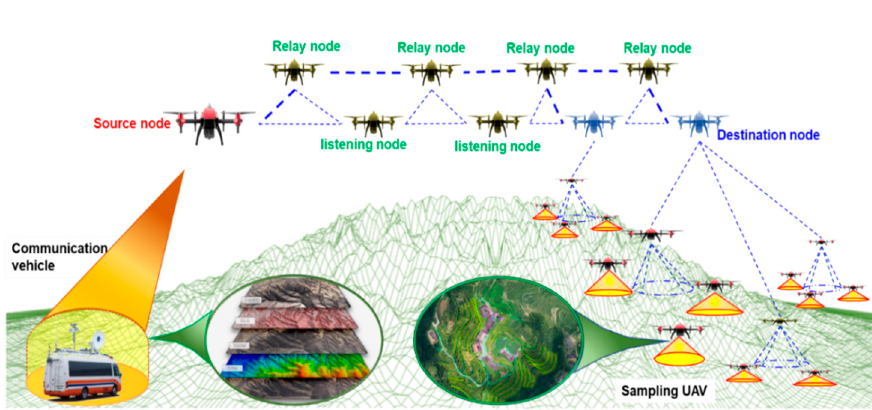
Figure 1. Diagram of cooperative communication two-phase communication